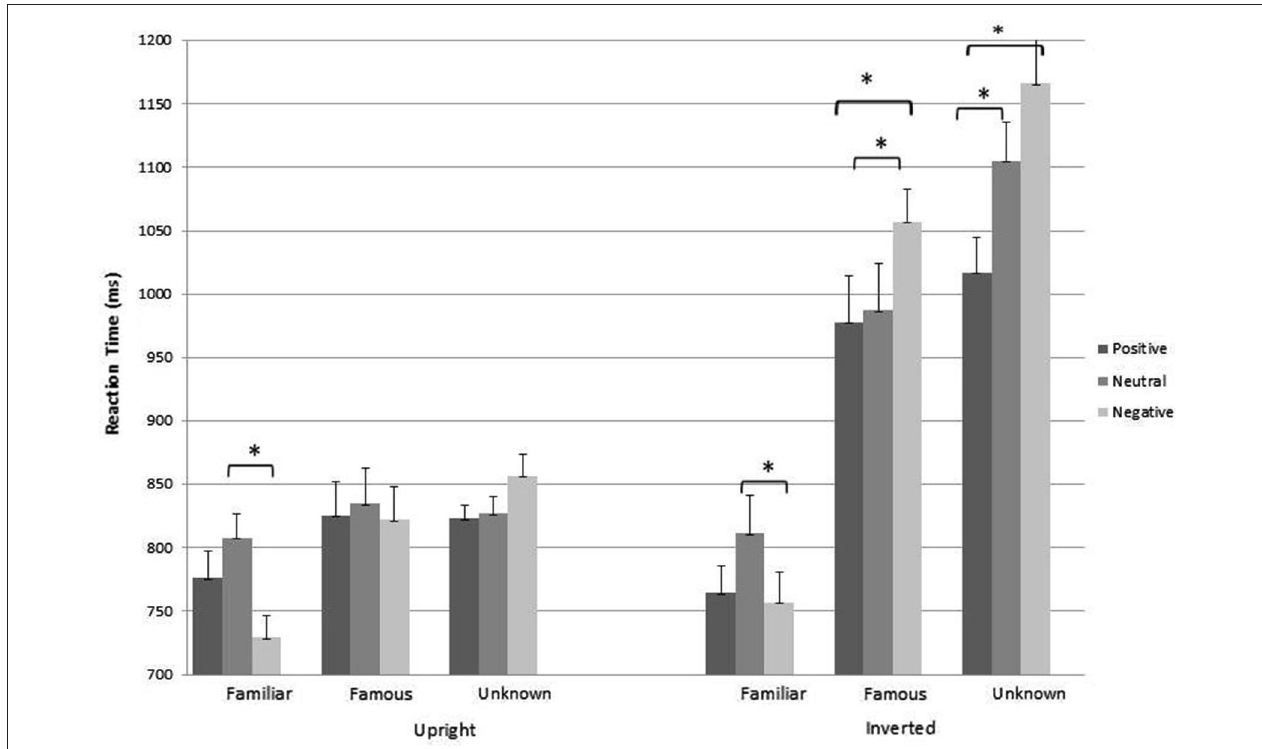
FIGURE 5 | Interaction between orientation, class and expression comparing for expression . Single asterisk indicates significance at p < 0.001.